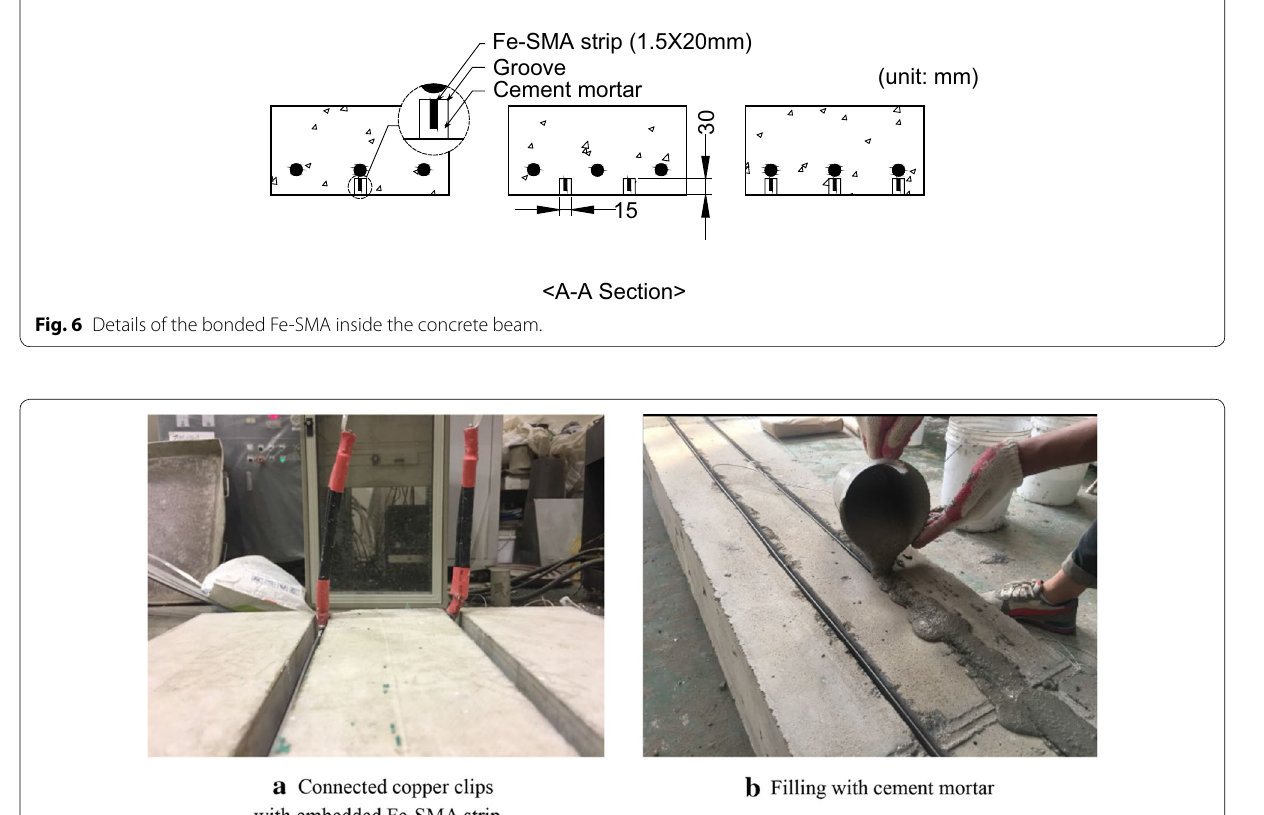
Fig. 7 Embedding Fe-SMA strip for the NSM